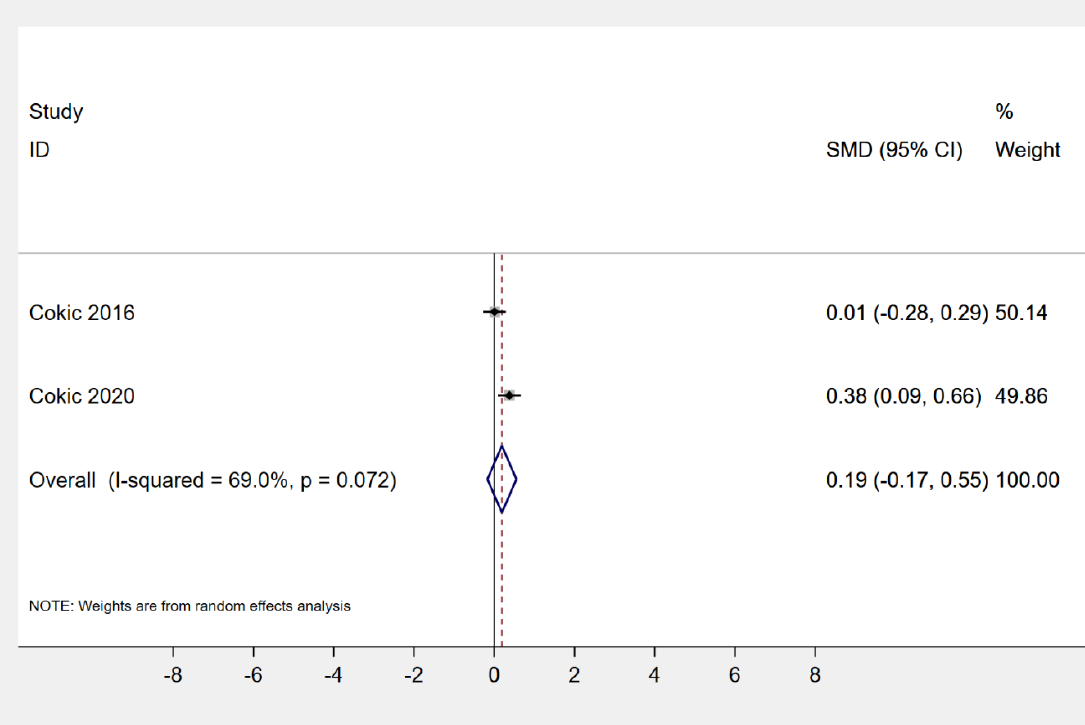
Figure 4. Cell viability by WST-1 assay, represented by % formazan reduction at 330 –400 μg/mL (nanocomposite, Filtek Supreme XTE; nanohybrid, GradiO).